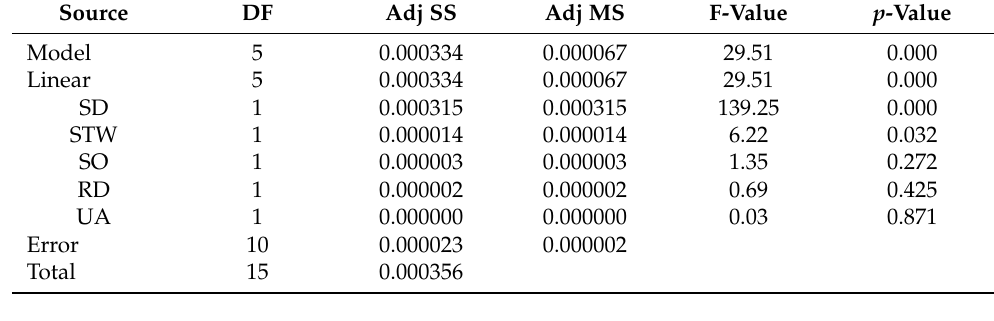
Table 5. Dispersion analysis of fractional factorial design for torque.